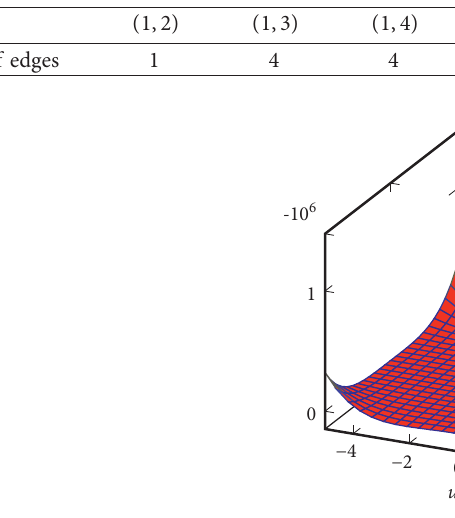
Figure 3: 3D plot of M-polynomial of dexamethasone D